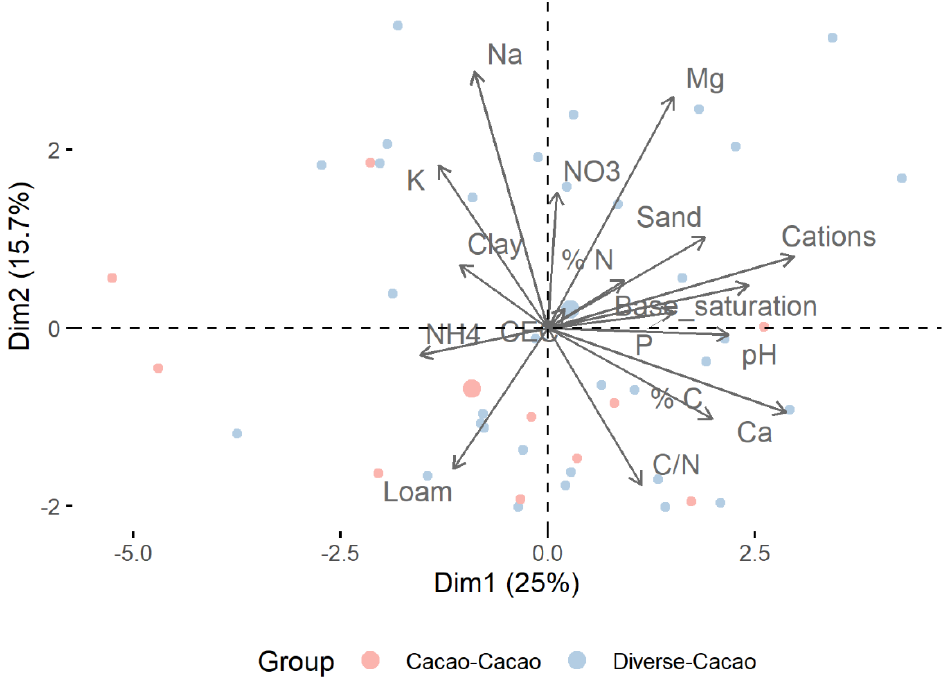
Figure 2. Principal components analysis (PCA) ordination of soil physicochemical properties. Soil sampled from cacao with adjacent shade trees (Diverse-Cacao treatment) clustered separately from cacao without adjacent shade trees in the same plot (Cacao-Cacao treatment). Points represent individual soil samples, and larger points represent group means. CEC: cation exchange capacity, C/N: carbon/nitrogen ratio.